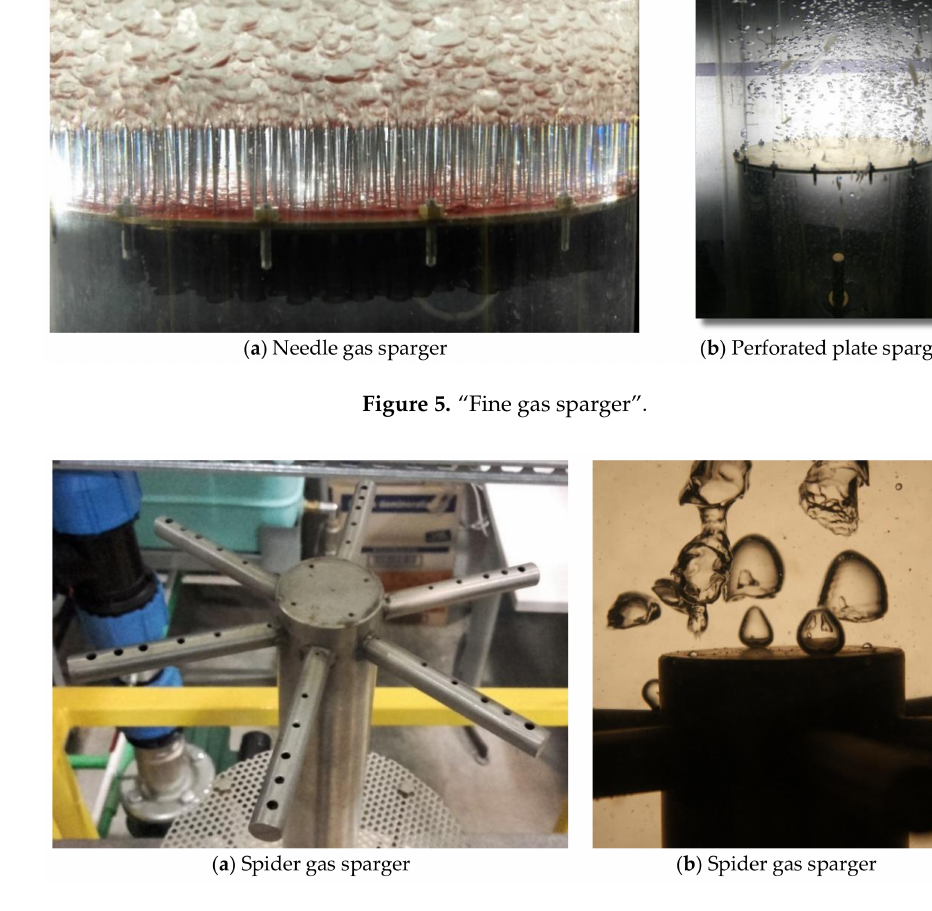
Figure 6. “Coarse gas